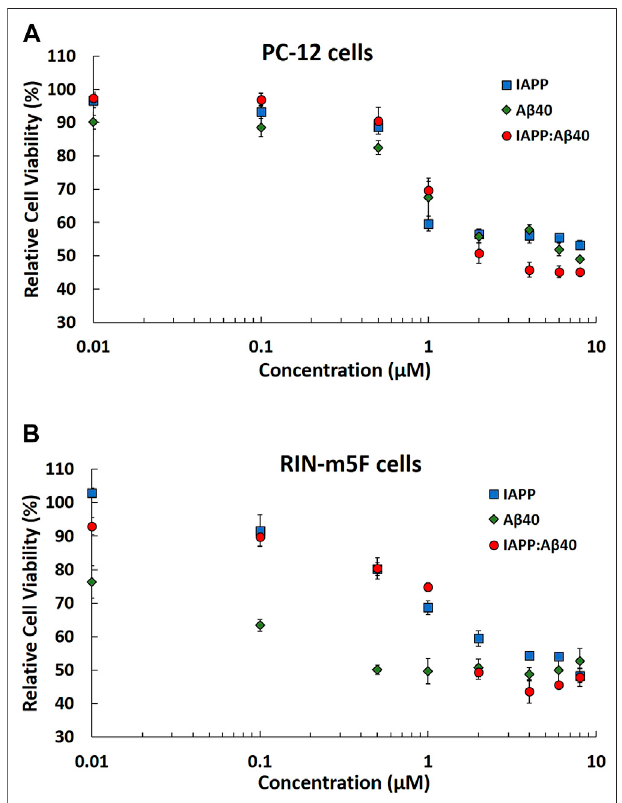
FIGURE 4 | MTT results showing the normalized cell viability rates of (A) PC-12 cells and (B) RIN-m5F cells after treatment with 96Hours-aged homo- aggregates(IAPP alone orA β 40alone) andhetero-aggregates (IAPP-A β 40)at increasing concentrations (10 nM – 8 µM). Normalized cell viability rates were calculated relative to control samples (cells without peptide treatment). Data represent mean ± SE ( n =